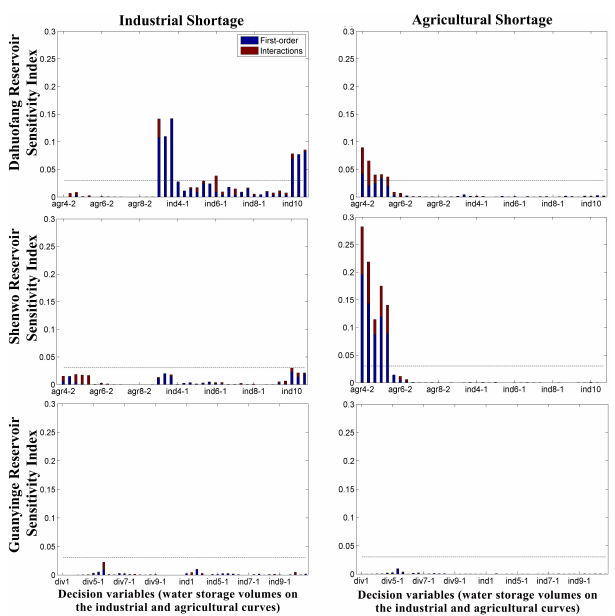
Figure 9. First-order and total-order indices for the inter-basin multi-reservoir operation problem regarding industrial shortage in- dex and agricultural shortage index. The x axis labels represent de- cision variables (water storage volumes on the industrial, agricul- tural and water transferring